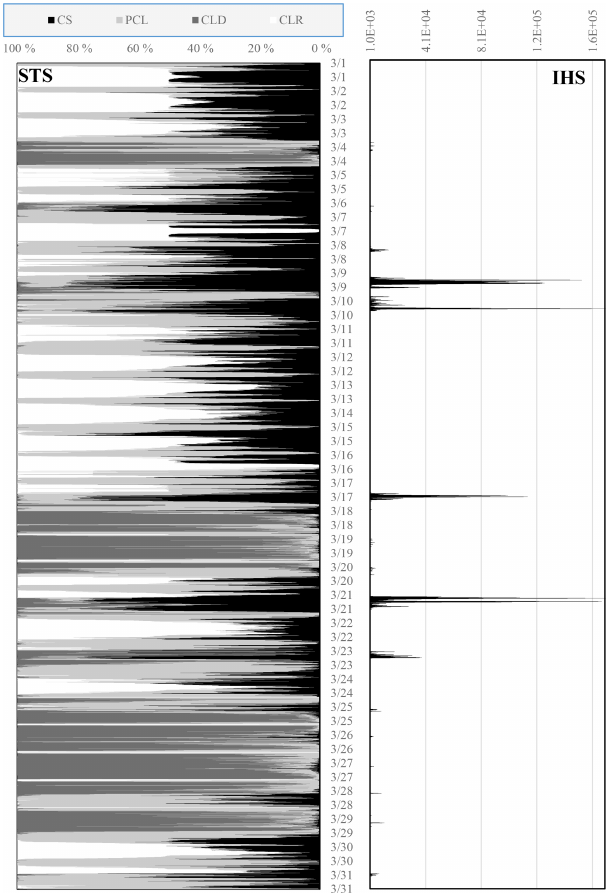
Figure 8. PSTS and IHS versus time for TSI images from SGP March 2018. Left panel shows the PSTS. Right panel: IHS broad- ening w = 3 .